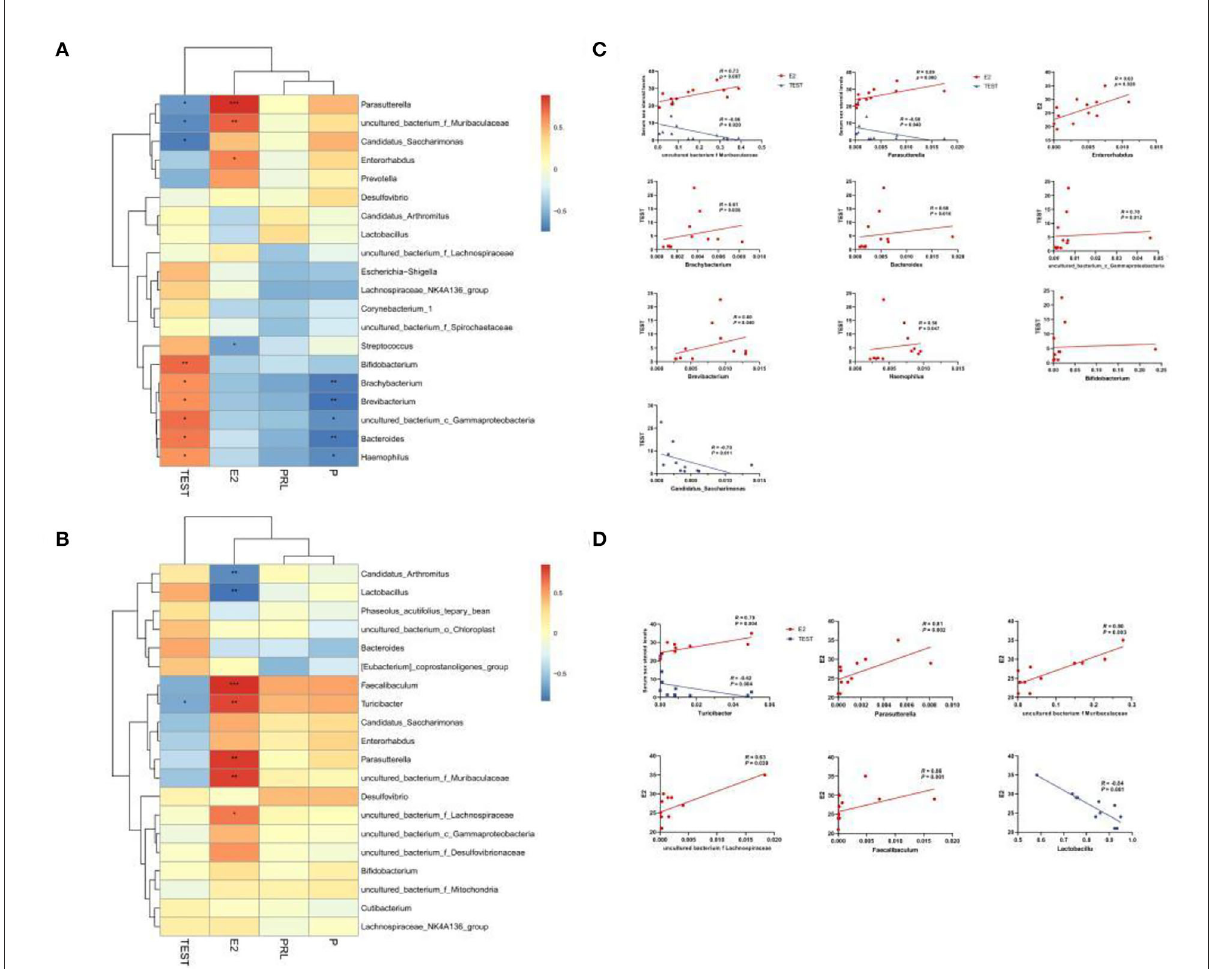
FIGURE8 Heatmap of MAM (A) and LM (B) correlations with sex steroid levels. In the heat map, red represents a positive correlation, and blue represents a negative correlation; the closer to red, the closer the R -value is to 1; the closer to blue, the closer the R -value is to − 1. In the linear correlation diagram of MAM (C) and LM (D) , the closer the R -value is to 1, the more obvious the correlation. * p < 0.05, ** p < 0.01, *** p <